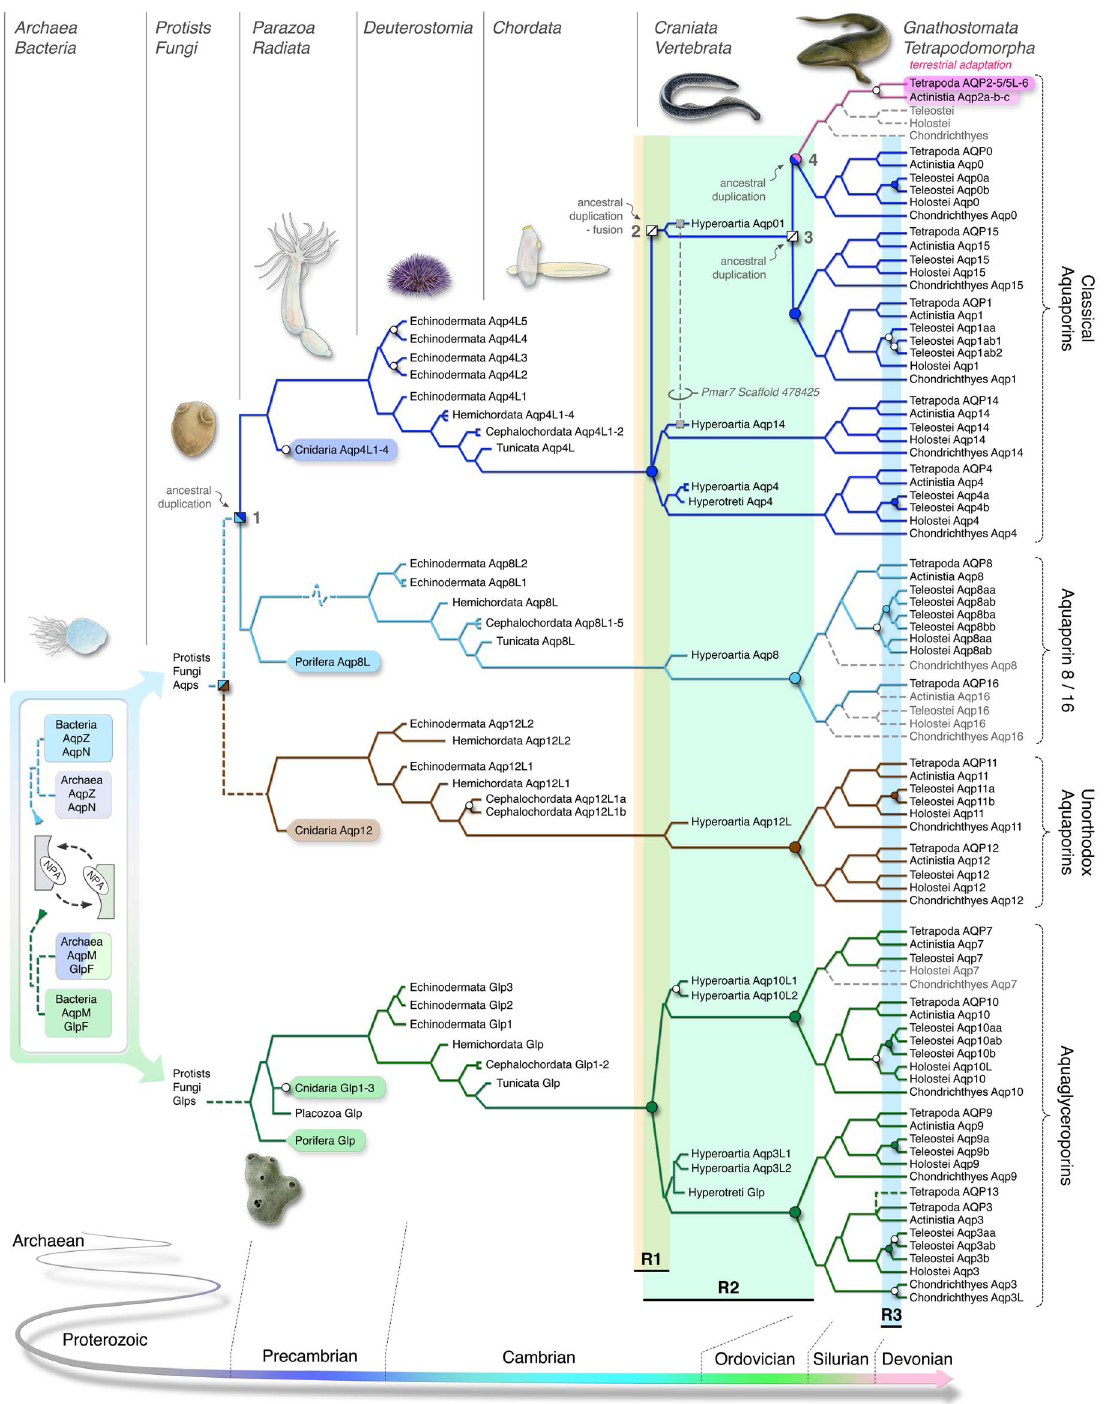
Figure 6. Evolutionary model and ancestry of the deuterostome aquaporin superfamily. Archaea and Bacteria are encapsulated in a putative ‘‘ring of life’’ scenario. Dotted lines indicate uncertain relationships. White nodes indicate tandem duplication, coloured nodes are associated with serial rounds (R1– R3) of whole genome duplication. The nomenclature and model are explained further in the text. The tetrapodomorph shown above node 4 is Tiktaalik roseae , which likely harboured the aqp2-like genes as shown for Actinistia and Dipnoi in Figure 2.